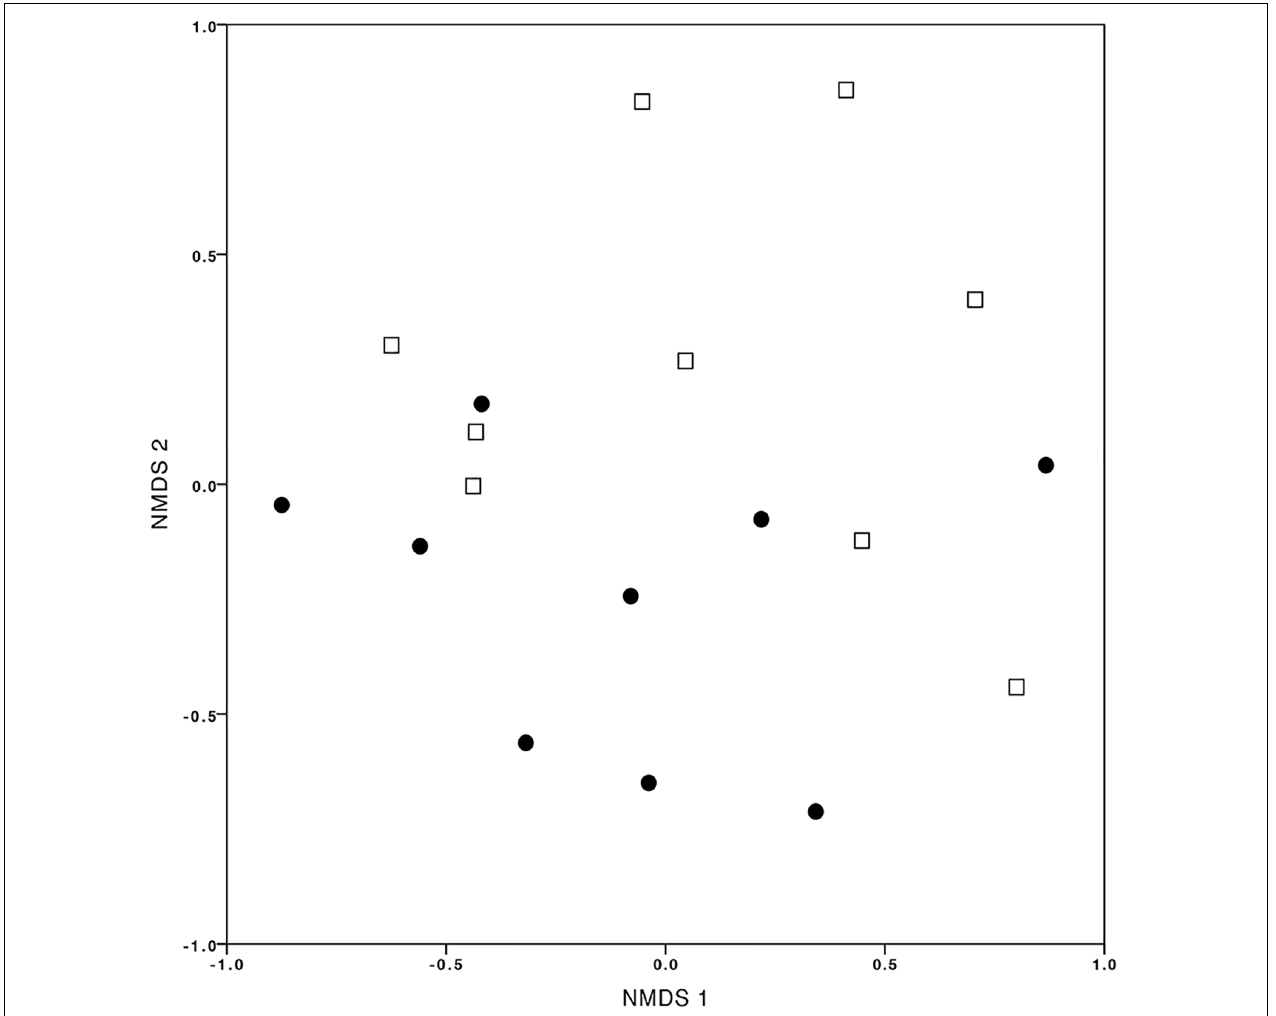
FIGURE 5 | Non-multidimensional scaling (NMDS) plot of orchid mycorrhizal fungal communities associated with Cyrtochilum retusum at T2 (black dots) and Q5 (white squares) sites (stress value = 0.070).